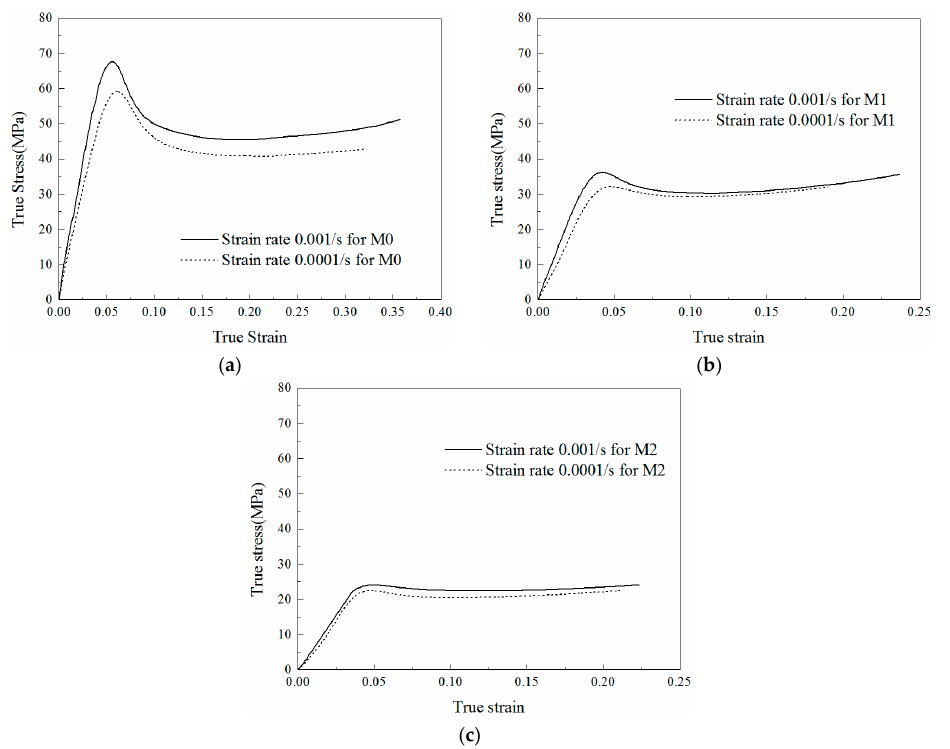
Figure 3. Comparison of compression stress versus compression strain plots under quasi-static loading for epoxy resin specimens with different content of LNBR: ( a ) 0% (M0); ( b ) 10% (M1); ( c ) 25% (M2).